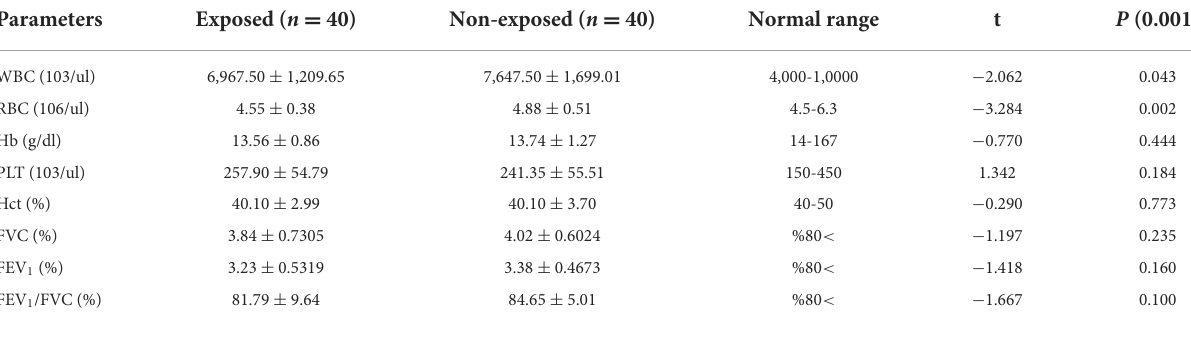
TABLE 3 Results of lung function parameters test in in workers exposed and not exposed. Respiratory status